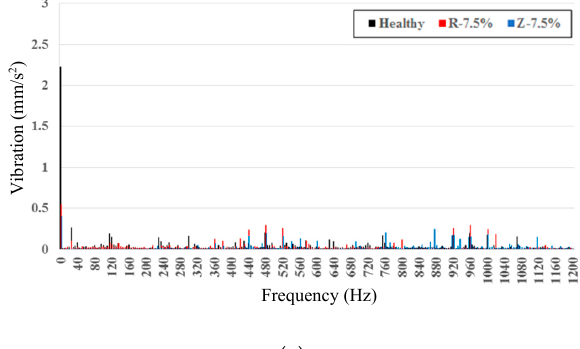
Figure 12. Electromagnetic force at a stator tooth calculated by 3D FEM: ( a ) electromagnetic force in the radial direction; ( b ) electromagnetic force in the circumferential direction.